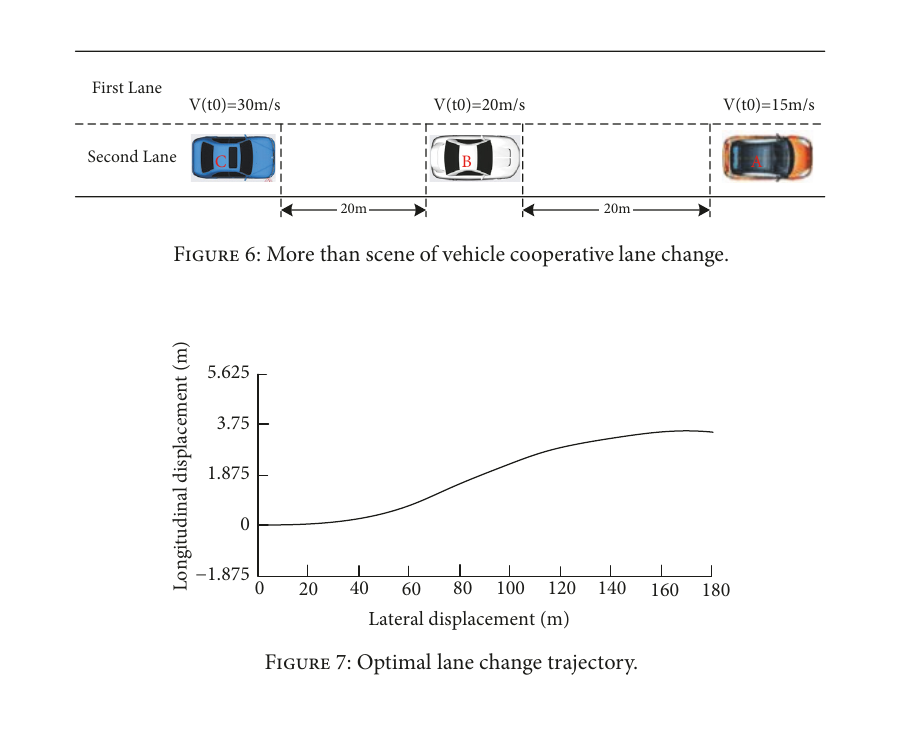
Table 1: Change of track conditions for reference